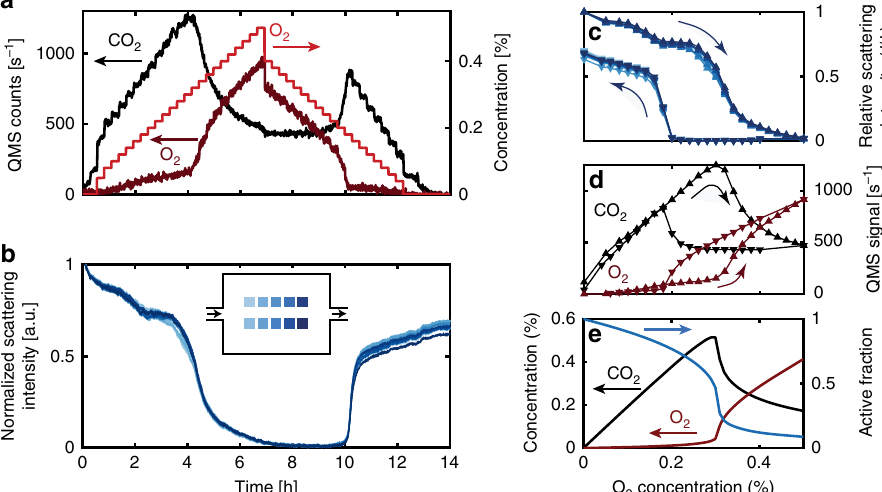
Fig. 4 CO oxidation experiments over 1000 Cu nanoparticles in the well-mixed reactor. During the entire experiment, the nominal inlet CO concentration was held constant at 7% and Ar was used as the carrier gas and the pressure at the inlet was 4 bar. a Time trace of the nominal O 2 inlet concentration in the gas feed (red) and of the outlet concentration of CO 2 (black) and O 2 (dark red) measured by the QMS. b Scattering intensity time evolution of the ten patches, each comprised of 100 nominally identical Cu nanoparticles. Inset is a schematic of the reactor with the nanoparticle array patches color-coded in blue with respect to their position in the bed. Arrows indicate fl ow direction. c Patch scattering intensity plotted as a function of nominal inlet O 2 concentration during the increase and decrease of the O 2 concentration. d Measured CO 2 and O 2 outlet concentrations plotted as a function of the nominal inlet O 2 concentration during the O 2 concentration increase (upward triangles) and decrease (downward triangles), respectively. e Simulated CO 2 production and active fraction of the catalyst calculated with a microkinetic model for a single continuously stirred tank reactor (CSTR). We note that the x -axis in ( c – e ) is the